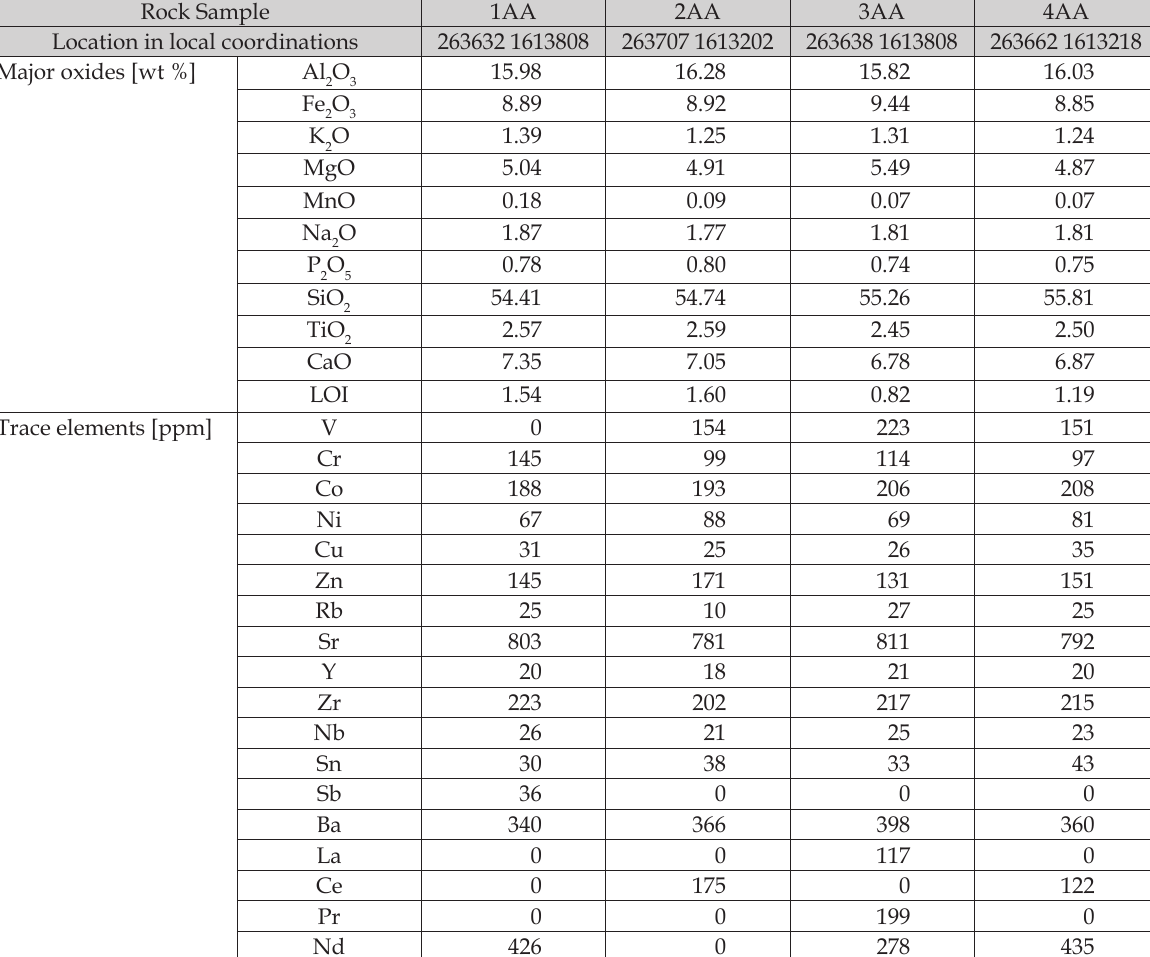
Table 1. Geochemical data presents major oxides and trace elements. Rock